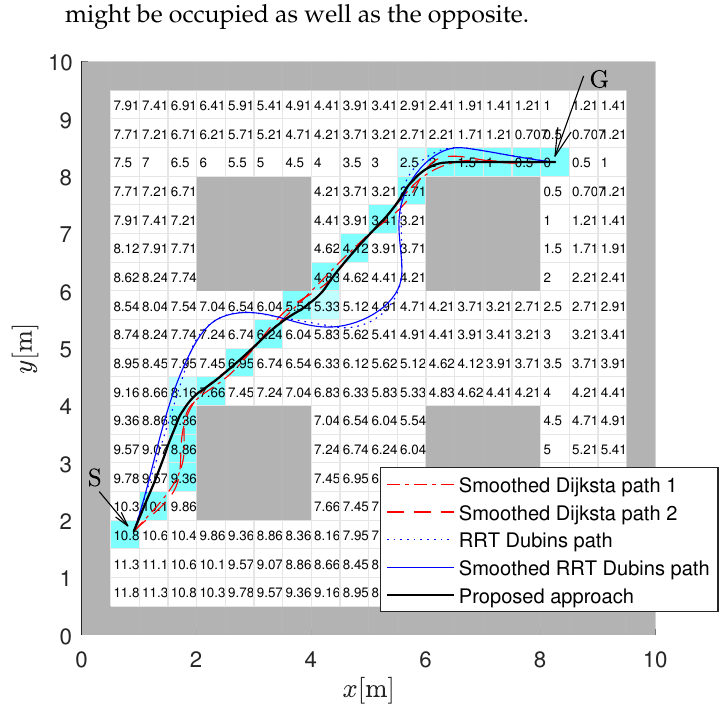
Figure 1. Static map of environment with start (S) and goal (G) locations, discrete CtG values assigned to the free cells (white cells, gray cells belong to obstacles) and some different smooth paths that connect the start and the goal